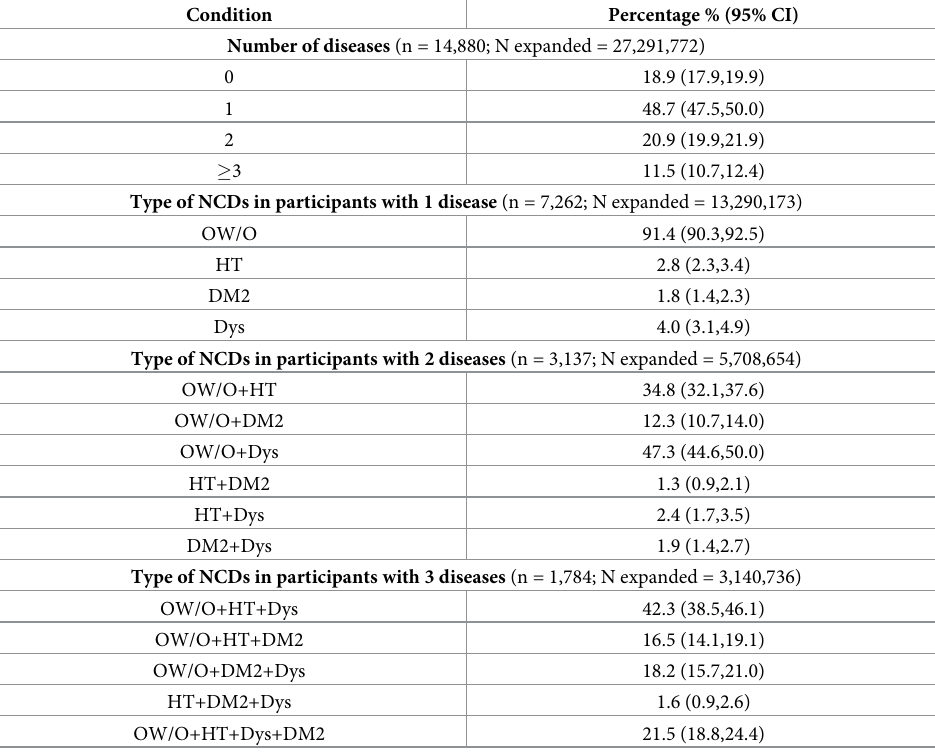
Table 2. Prevalence of number and type of non-communicable diseases in Mexican population.